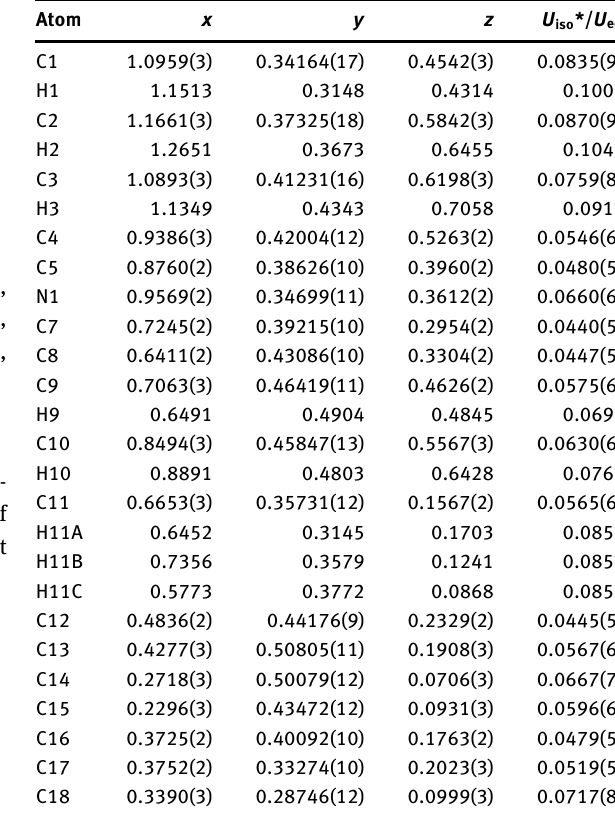
Table 2: Fractional atomic coordinates and isotropic or equivalent isotropic displacement parameters (Å 2